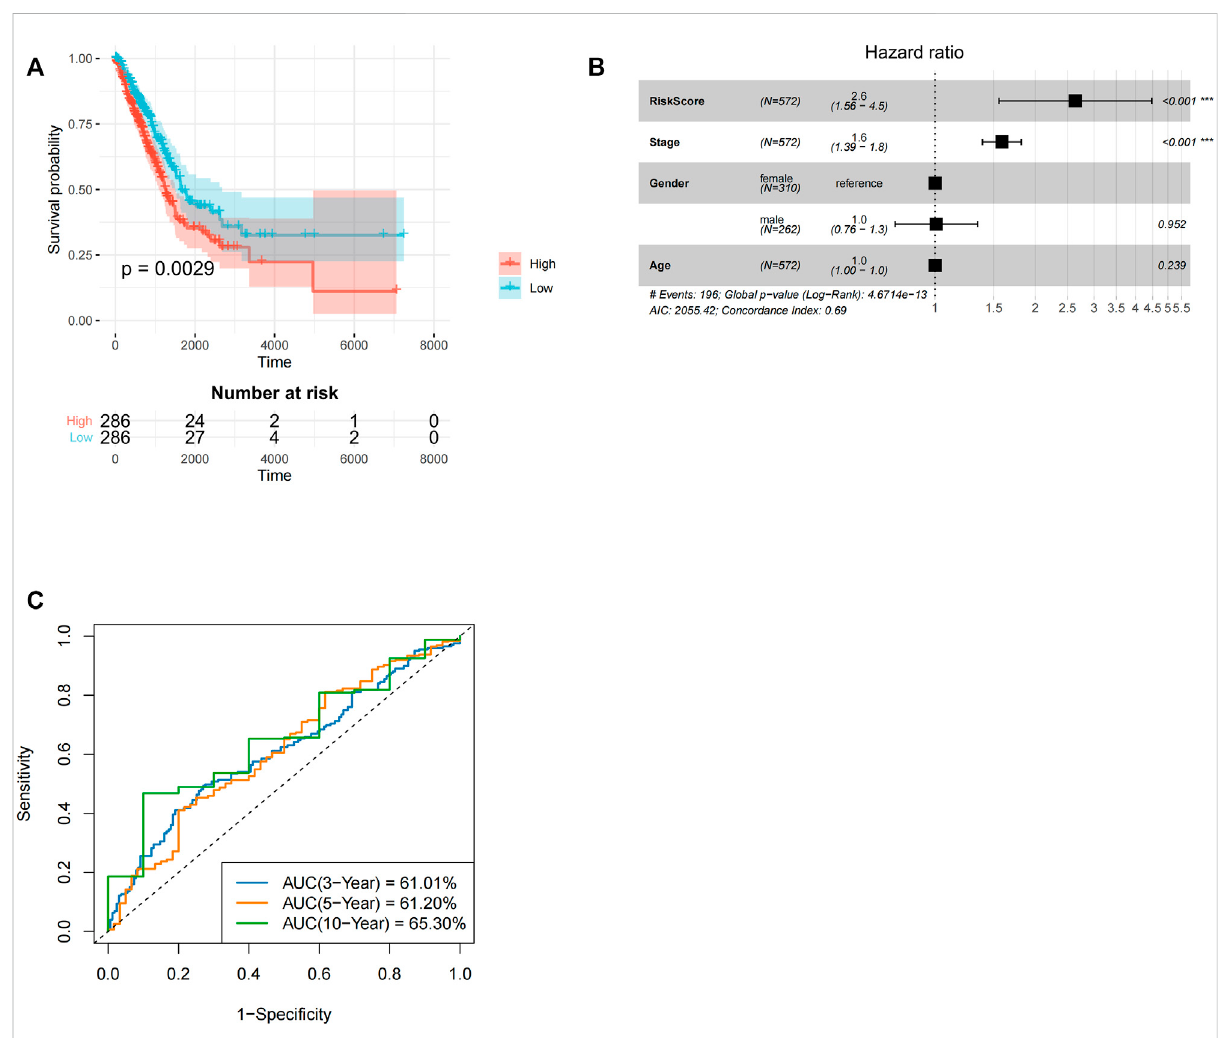
FIGURE 3 DevelopmentandsubsequentvalidationofTANlncSiginthelungadenocarcinomaTCGAtestingaswellasdiscoverydatasets. (A) Kaplan-Meier survivalanalysesforLUADpatients. (B) AnanalysisoftheTCGAdatasetofLUADpatientsusingmultivariateCoxregression. (C) ROCcurveanalysesof patients with LUAD in the TCGA